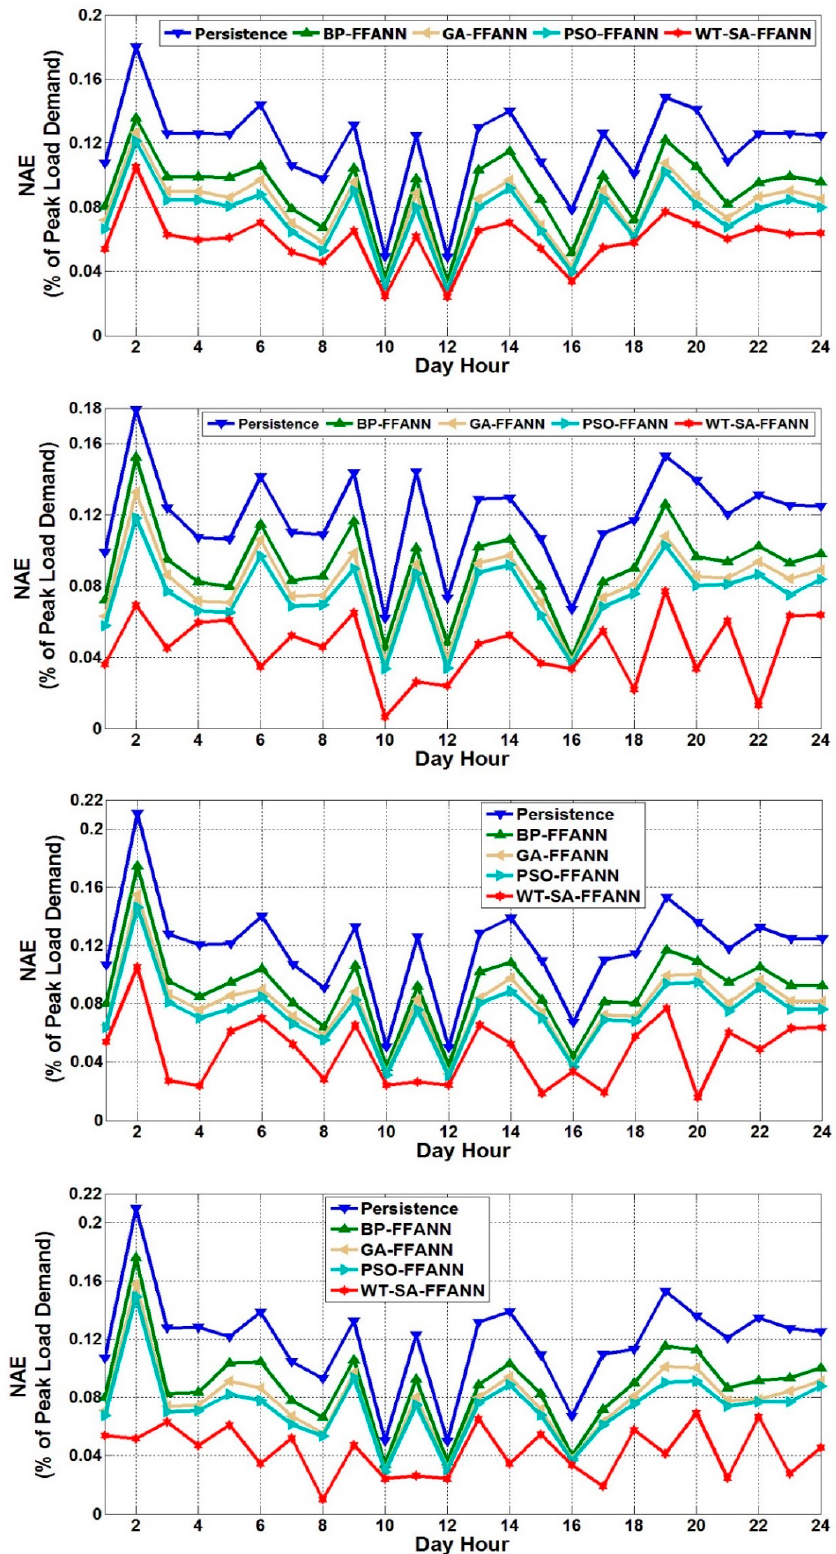
Figure 13. NAE for weekdays (the first curve for the winter weekday, second curve for the spring weekday, third curve for the spring weekday and fourth curve for the fall weekday).